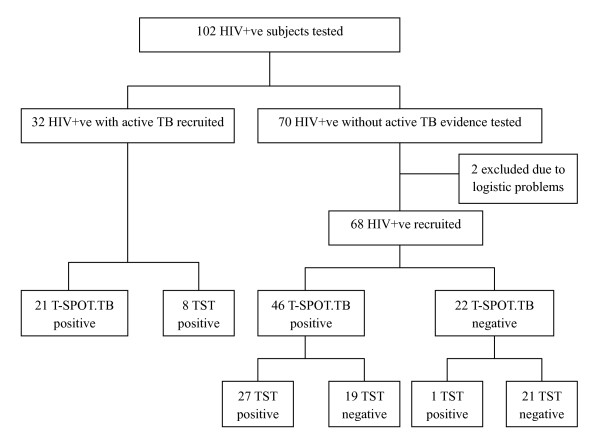
Flow chart showing numbers recruited in HIV-positive (HIV+ve) individuals with or without active tuberculosis. TB = tuberculosis; TST = tuberculin skin test; T-SPOT.TB: commercial test IFNGAR from Oxford Immunotec, Abingdon, UK.